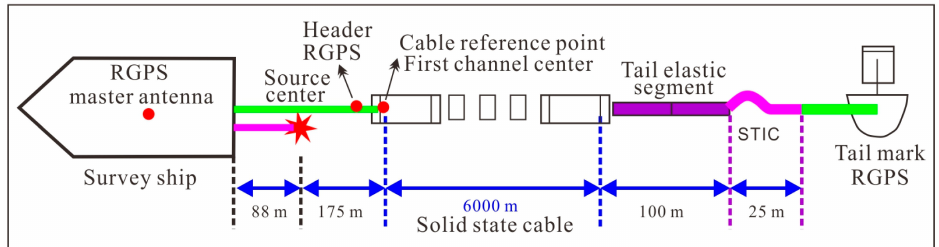
Figure 3. Relative position of the seismic source and cable.